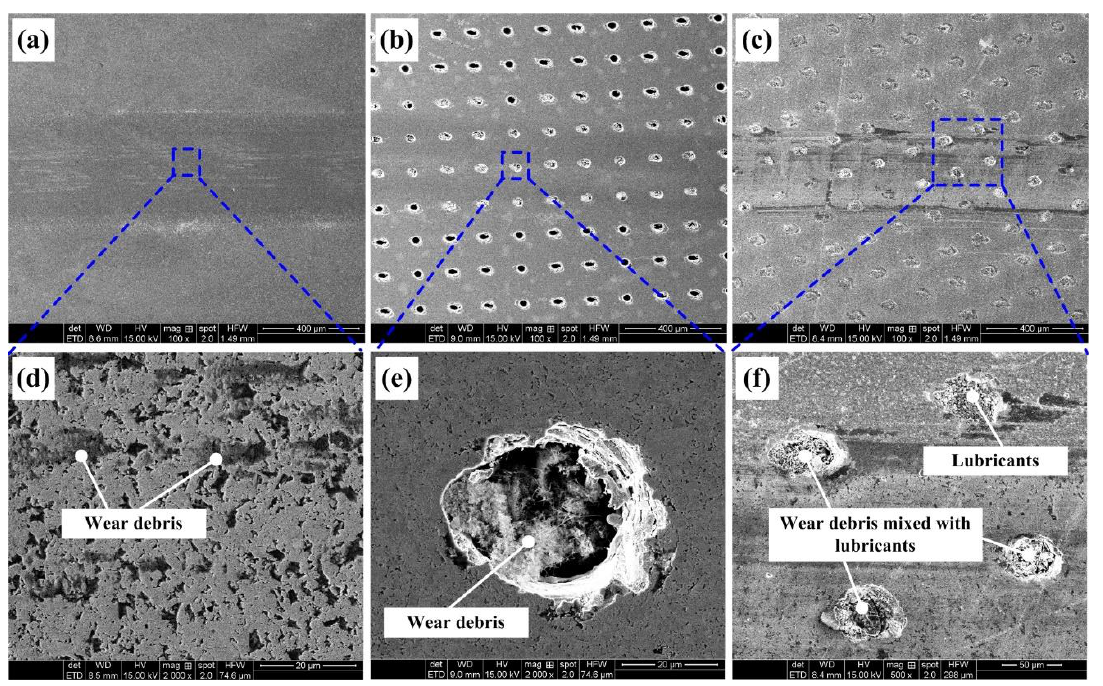
Figure 11. Wear tracks of different samples at sliding speed of 40 m/min: ( a ) SS, ( b ) TD150, ( c ) TD150 filled with lubricants, ( d ) enlarged view for SS, ( e ) enlarged view for TD150 and ( f ) enlarged view for TD150 filled with lubricants.